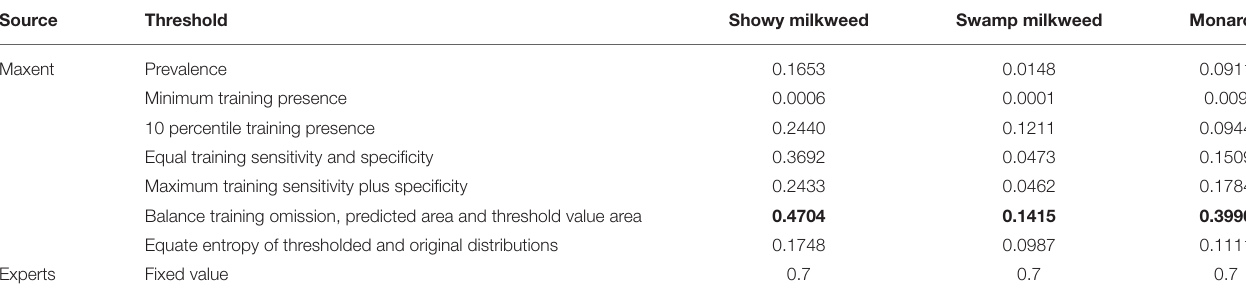
TABLE 3 | Maxent modeled and expert opinion-based thresholds used in aiding interpretation of habitat